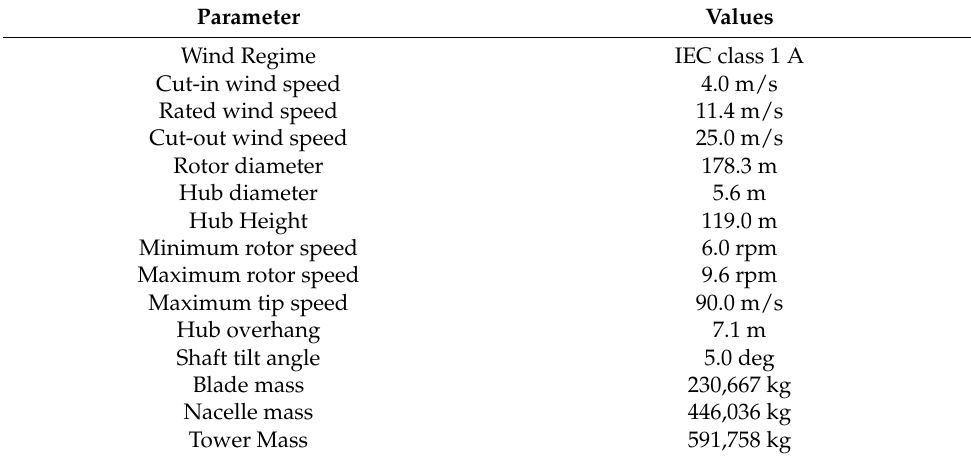
Table 1. Specification of DTU 10 MW wind turbine.